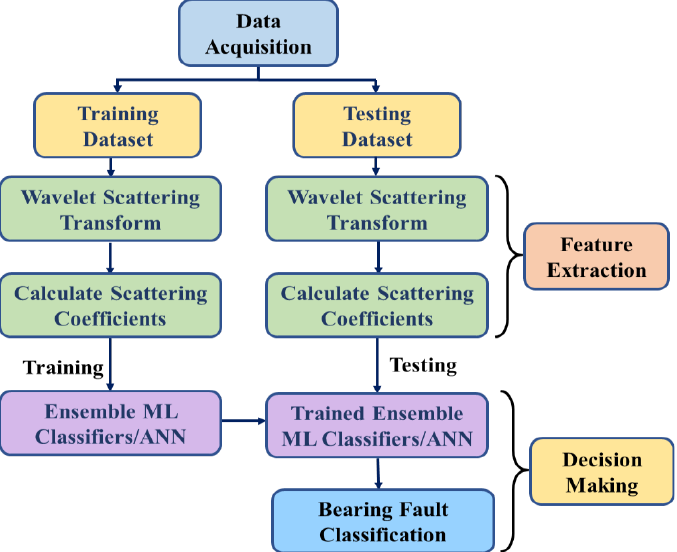
Figure 7. The fault classification method based on the WST and ensemble ML classifiers.